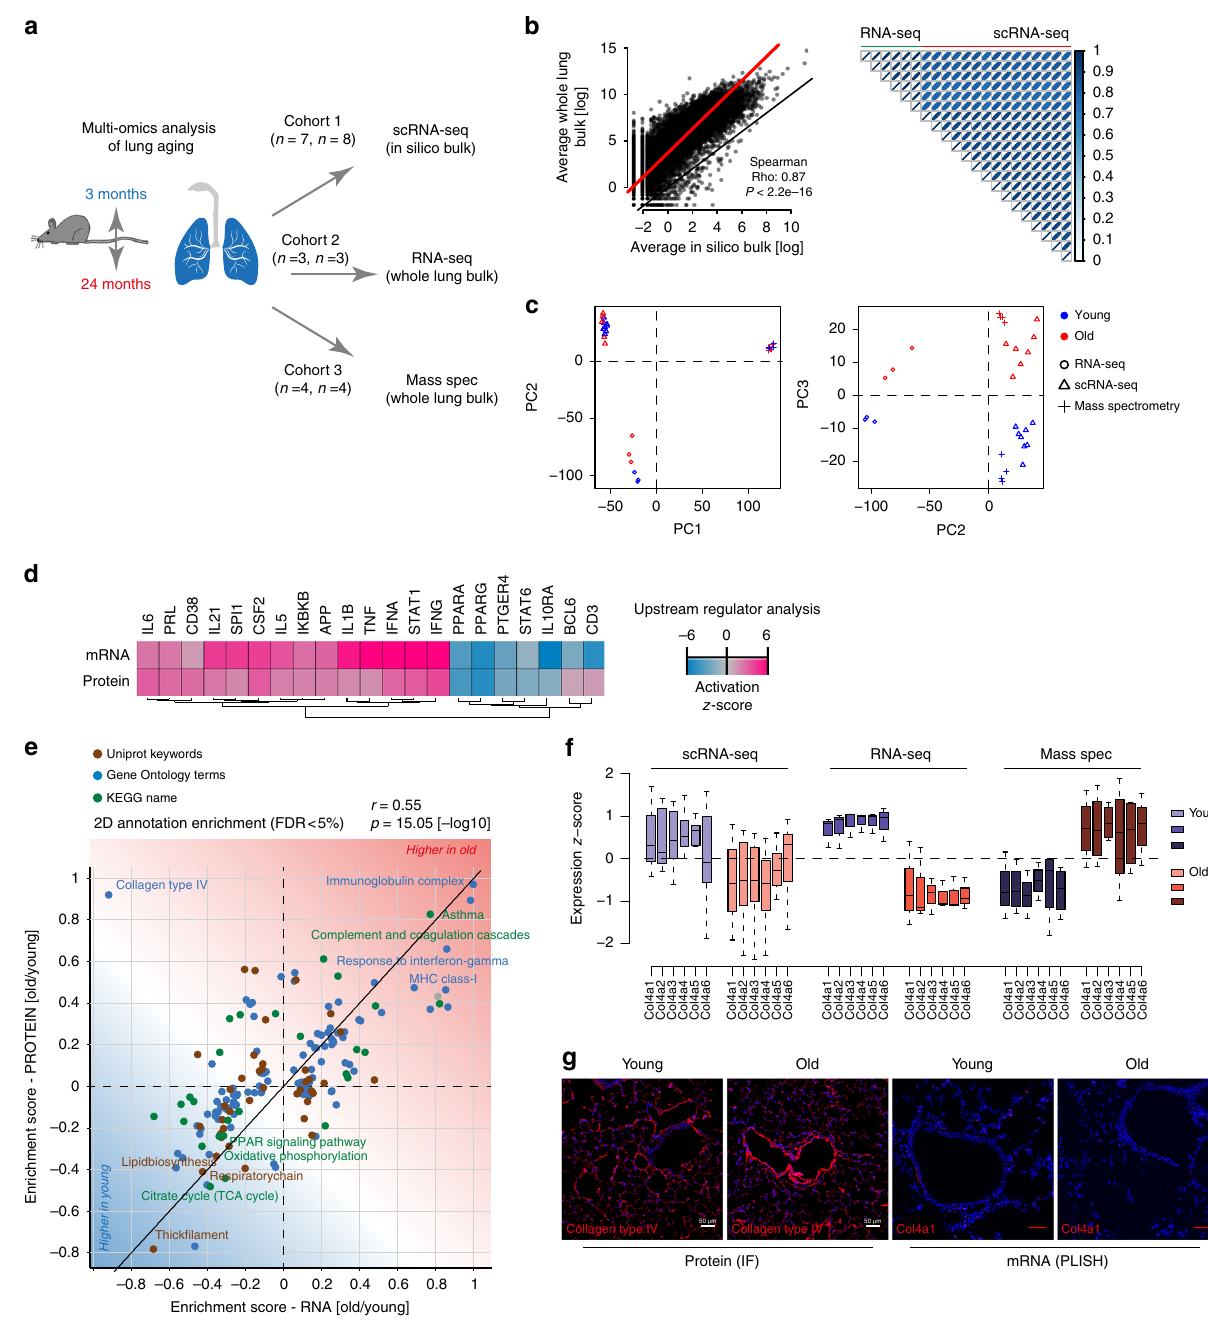
type. We analyzed age-dependent alterations of relative fre- quencies of the 30 cell types represented in our dataset. Since the cell-type frequencies are proportions, the data are compositional. Therefore, it is impossible to statistically discern if a relative change in cell-type frequency is caused by the increase of a given cell type or the decrease of another. However, after performing dimension reduction using multidimensional scaling of the cell- type proportions, we observed a signi fi cant association between the fi rst coordinate and age (Fig. 4a, b; Wilcoxon test, p < 0.005), indicating that cell-type frequencies differed between young and old mice. Interestingly, the Dropseq data showed a relative increase in ciliated cells in old mice so that the ratio of club to ciliated cells was altered (Fig. 4c, d). Relative frequency differ- ences in scRNA-seq data can be biased by tissue isolation